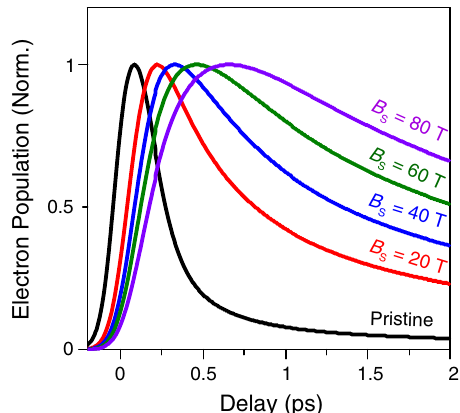
Fig. 4 Theoretical modeling of carrier dynamics under the in fl uence of pseudo-magnetic fi elds. Calculated electron population in the probe energy states as a function of the delay time for strained graphene with different pseudo-magnetic fi elds ( B S ) of 0 T (black), 20 T (red), 40 T (blue), 60 T (green), and 80 T (purple). All graphs are normalized. With the increased pseudo-magnetic fi eld intensity, the rise time increases signi fi cantly up to 800 fs for B S = 80